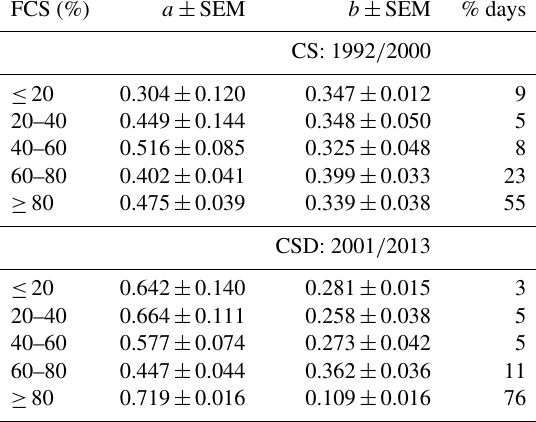
Table 2. The a and b coefficients obtained between 1992 and 2000 for the CS recorder and between 2001 and 2013 for the CSD recorder, as a function of FCS (fraction of clear sky, %) and % of days used (see García et al., 2014b). SEM is standard error of the